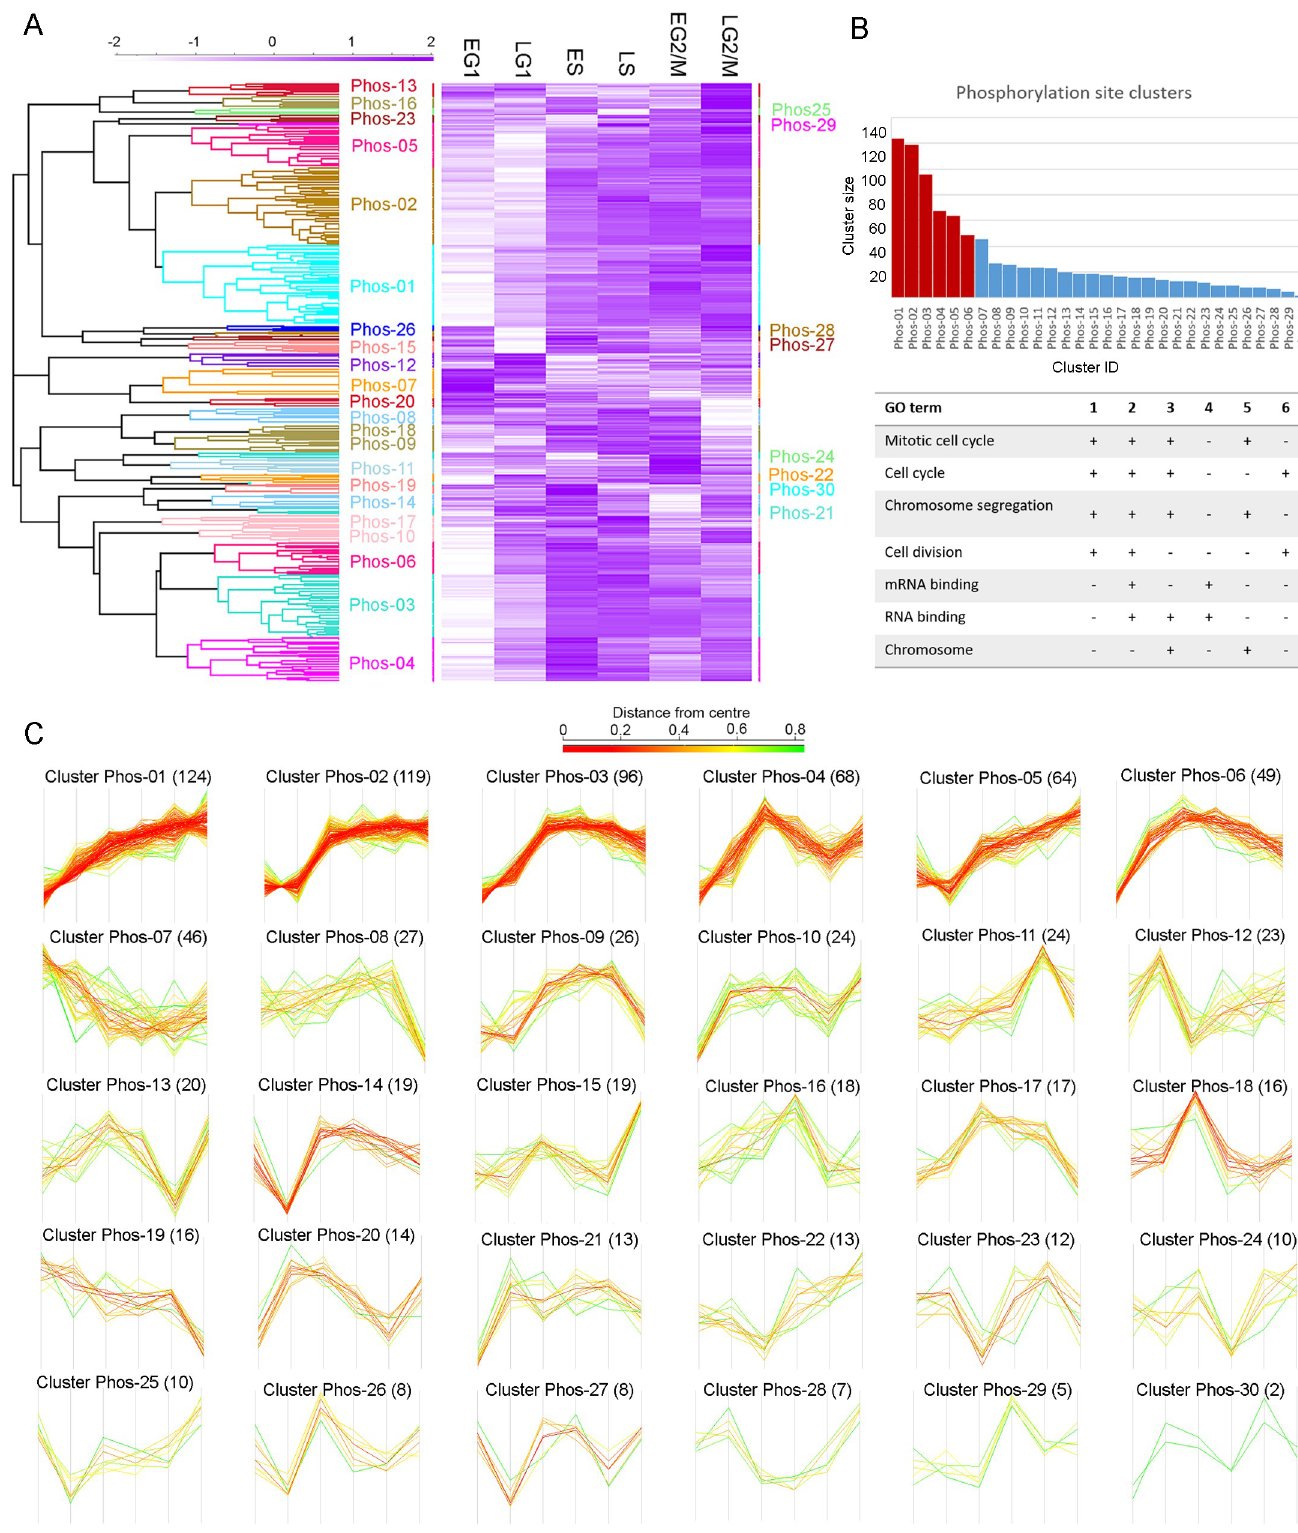
Fig 4. Hierarchical clustering of cell cycle regulated phosphorylation sites. A. Unrestrained hierarchical clustering was performed using Euclidean distance of the complete linkage, generating 30 clusters (Phos-01 to Phos-30). The relationship between the clusters is rendered as a tree, and the profiles are rendered as a heat